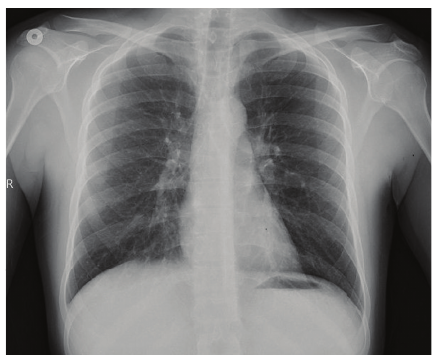
Figure 2: The chest X-ray of patient in the first